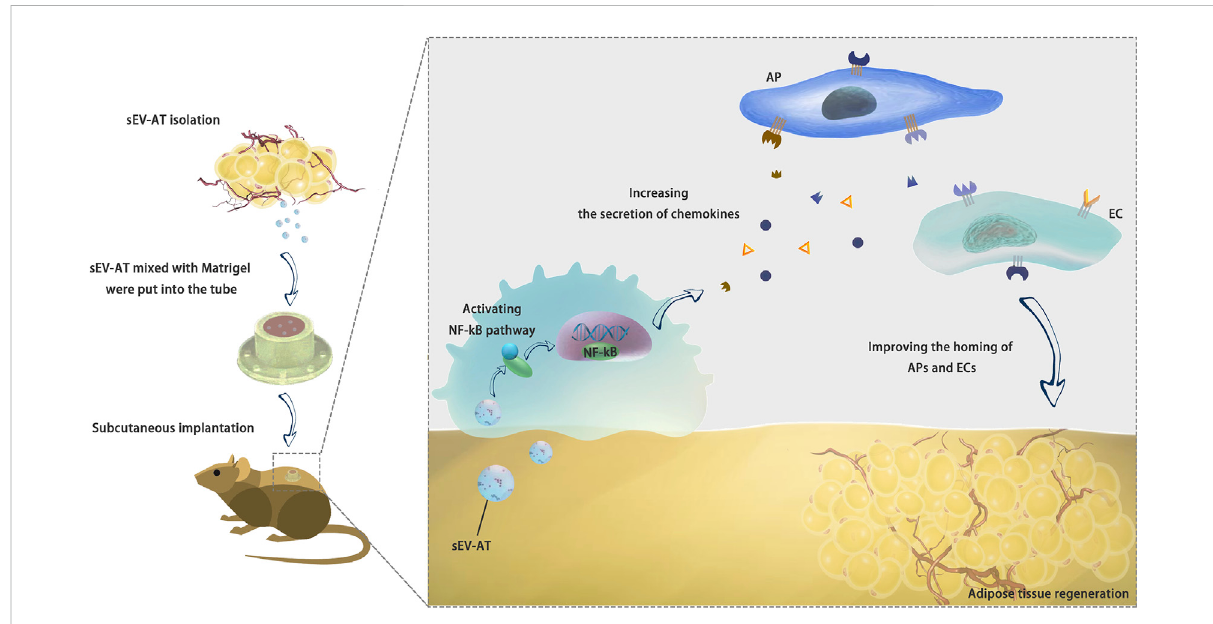
FIGURE 8 Conclusion.sEV-ATmightregulatethesecretionofchemokines via activatingNF-kBsignalingpathwayinmacrophagestoimprovethehoming of APs and ECs and facilitate adipose tissue